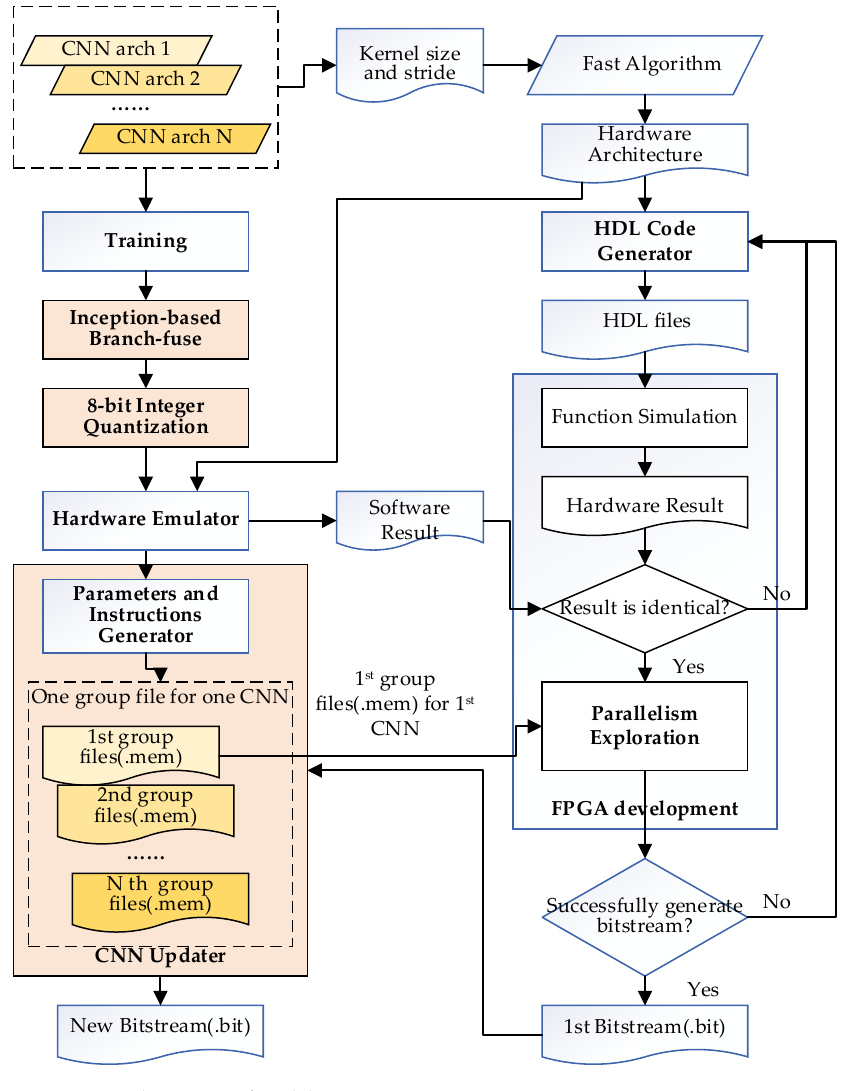
Figure 1. Architecture of toolchain.